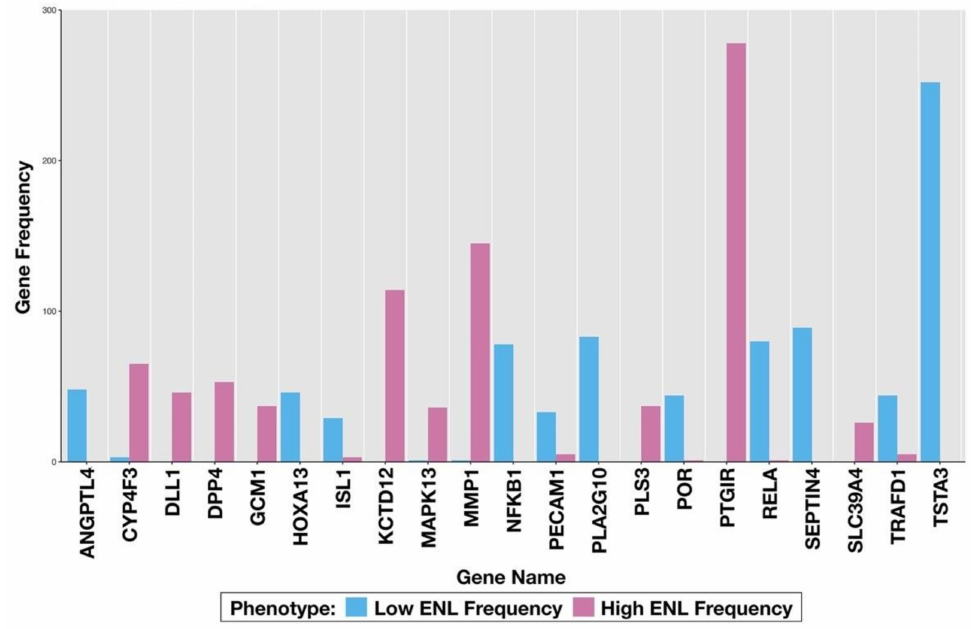
Figure 5. Genes with a frequency of 5% or higher in the top 500 LDA classifiers from flaxseed lignan vs. placebo intervention in each of the two ENL phenotypes. Gene frequencies were determined by their appearance in the top (with respect to their bresub error) 500 LDA three-gene